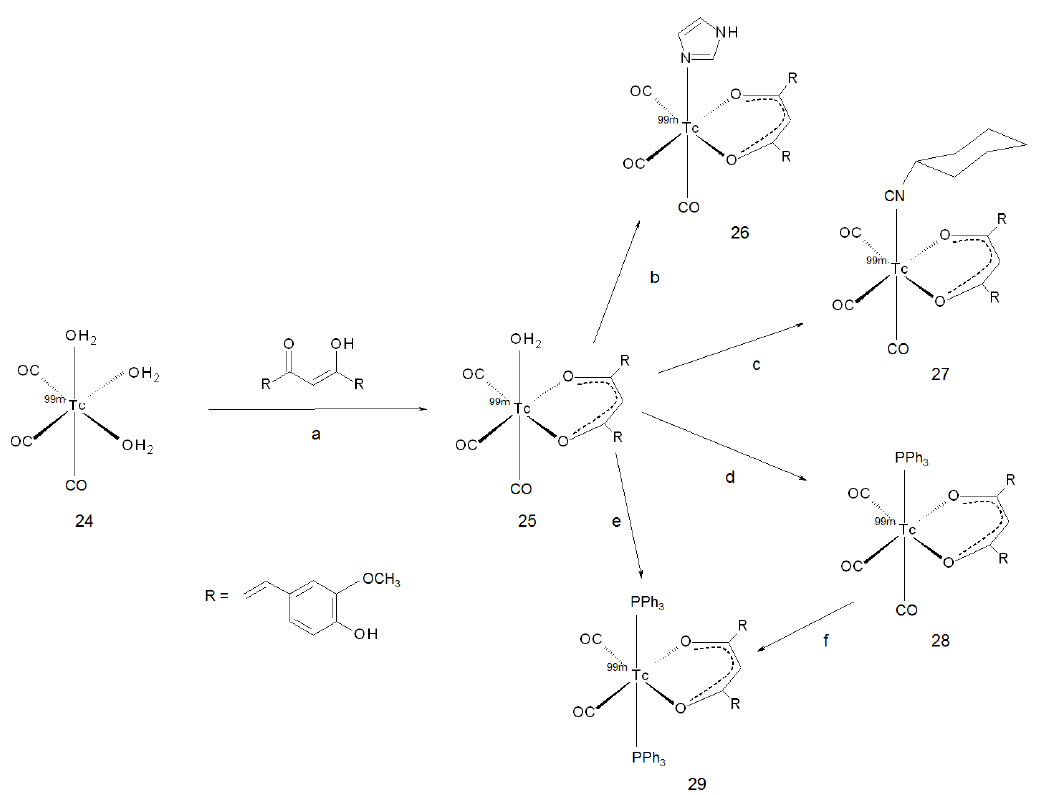
Figure 9. Reagents and conditions: ( a ) curcumin, DMSO 70 °C, 15 min; ( b ) imidazole, DMSO, 70 °C, 30 min; ( c ) isocyano- cyclohexane, DMSO, RT, 30 min ( d ) triphenylphosphine, MeOH, RT, 20 min; ( e ) triphenylphosphine, MeOH, 60 °C, 20 min; ( f ) triphenylphosphine, MeOH, 60 °C, 20 min.